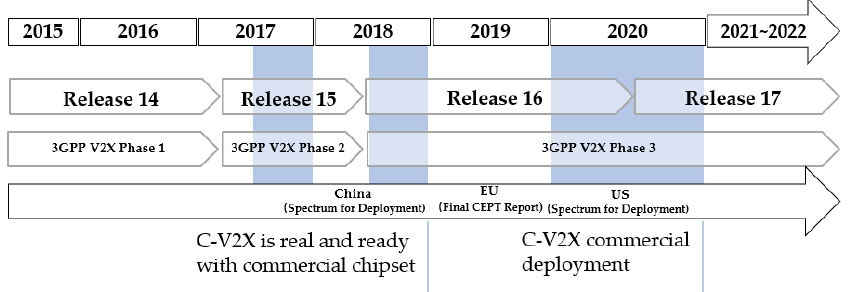
Figure 3. C-V2X 3GPP standard and deployment milestone